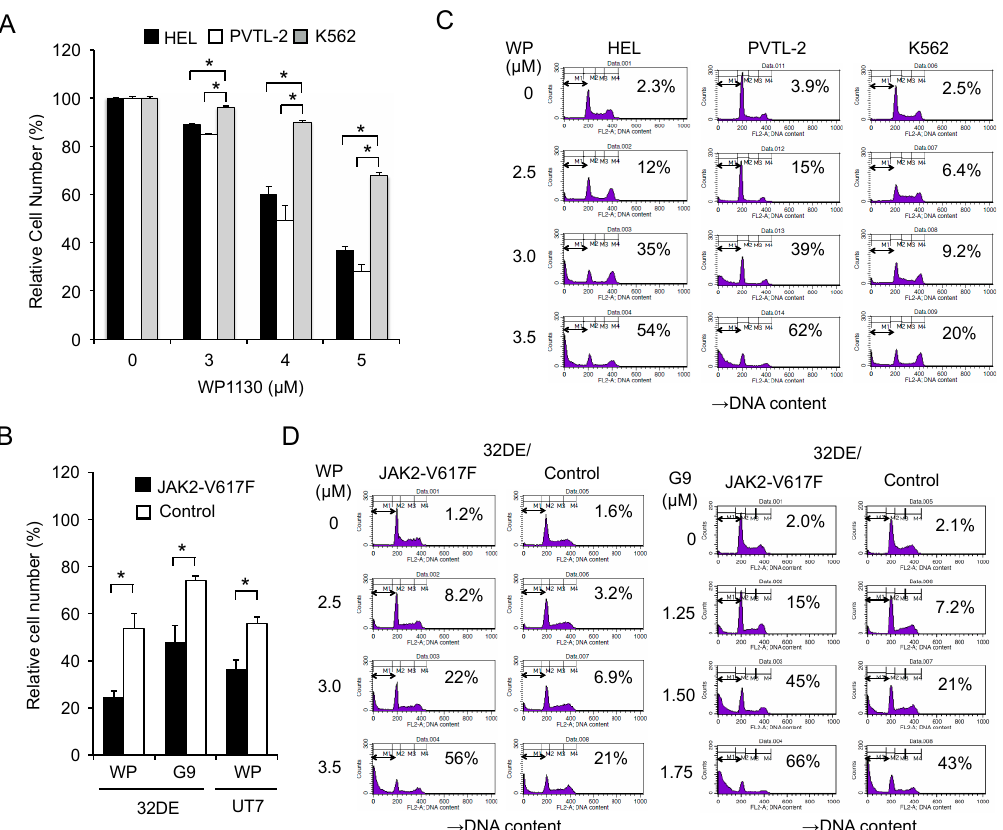
Figure 1. The USP9X inhibitor WP1130 or G9 induces apoptosis more prominently in JAK2-V617F-dependent cells than in cells dependent on BCR / ABL or cytokine-activated JAK2. ( A ) HEL, PVTL-2, and K562 cells were treated with indicated concentrations of WP1130 for 24 h, and viable cell numbers were measured by the CCK-8 colorimetric assay. Each data point represents the mean of triplicate cultures, with error bars indicating standard errors, and is expressed as percentage of the cell numbers cultured without WP1130. The asterisks indicate significant di ff erences between K562 and HEL or PVTL-2 determined by one-way ANOVA followed by Dunnett’s post-hoc test (* p < 0.05). ( B ) 32DE or UT7 cells transduced with either JAK2-V617F or empty vector (Control) and cultured with Epo were left untreated as control or treated for 24 h with 3 µ M WP1130 (WP) or 2 µ M G9, as indicated, in triplicate, and viable cell numbers were measured. The asterisks indicate significant di ff erences between JAK2-V617F and control cells determined by Student’s t-test (* p < 0.05). ( C ) HEL, PVTL-2, and K562 cells were treated for 24 h with indicated concentrations of WP1130. Cells were analyzed for cellular DNA content by flow cytometry. Percentages of apoptotic cells with the sub-G1 DNA content are indicated. ( D ) 32DE / JAK2-V617F cells (JAK2-V617F) or vector-control cells (Control) cultured with Epo were treated for 5 h with indicated concentrations of WP1130 or G9 and